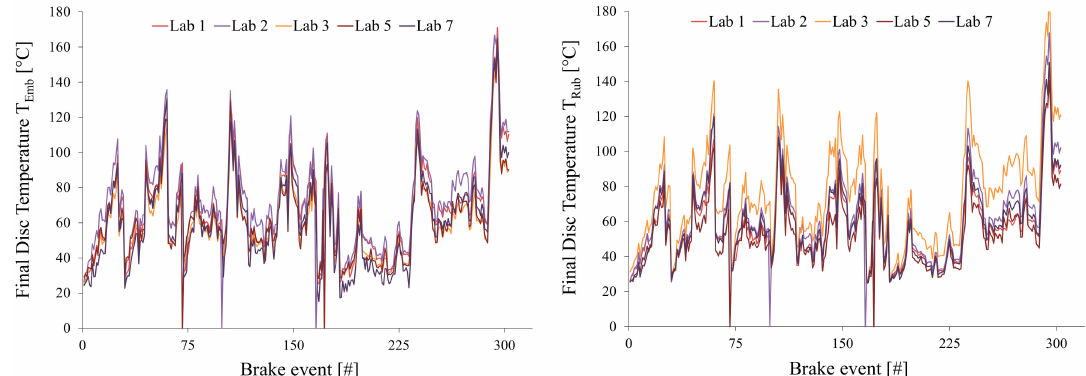
Figure 9. Final disc temperature profile measured by TC Emb ( left-hand side ) and TC Rub ( right-hand side ) for R1 during T1.